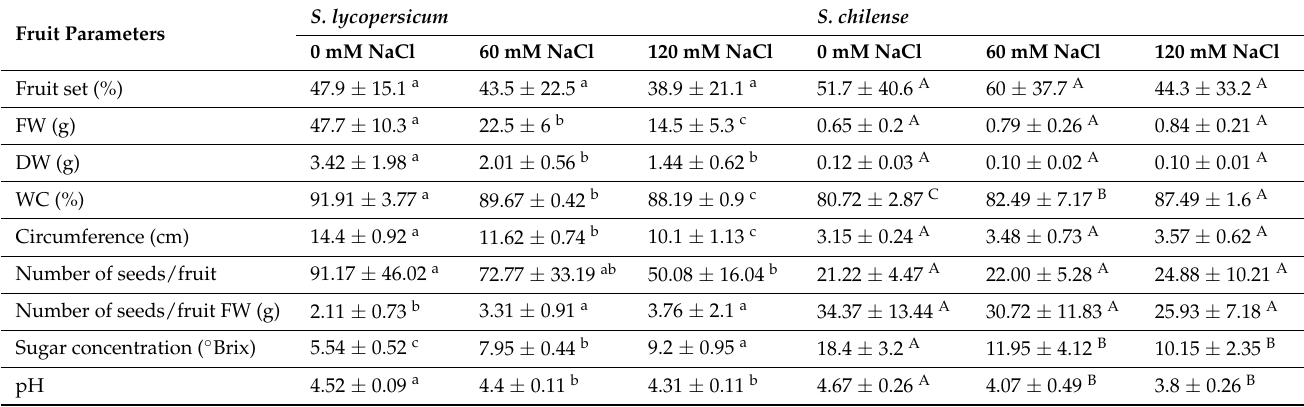
Table 3. Effects of salt stress on fructification parameters of Solanum lycopersicum and Solanum chilense grown at 0, 60, and 120 mM